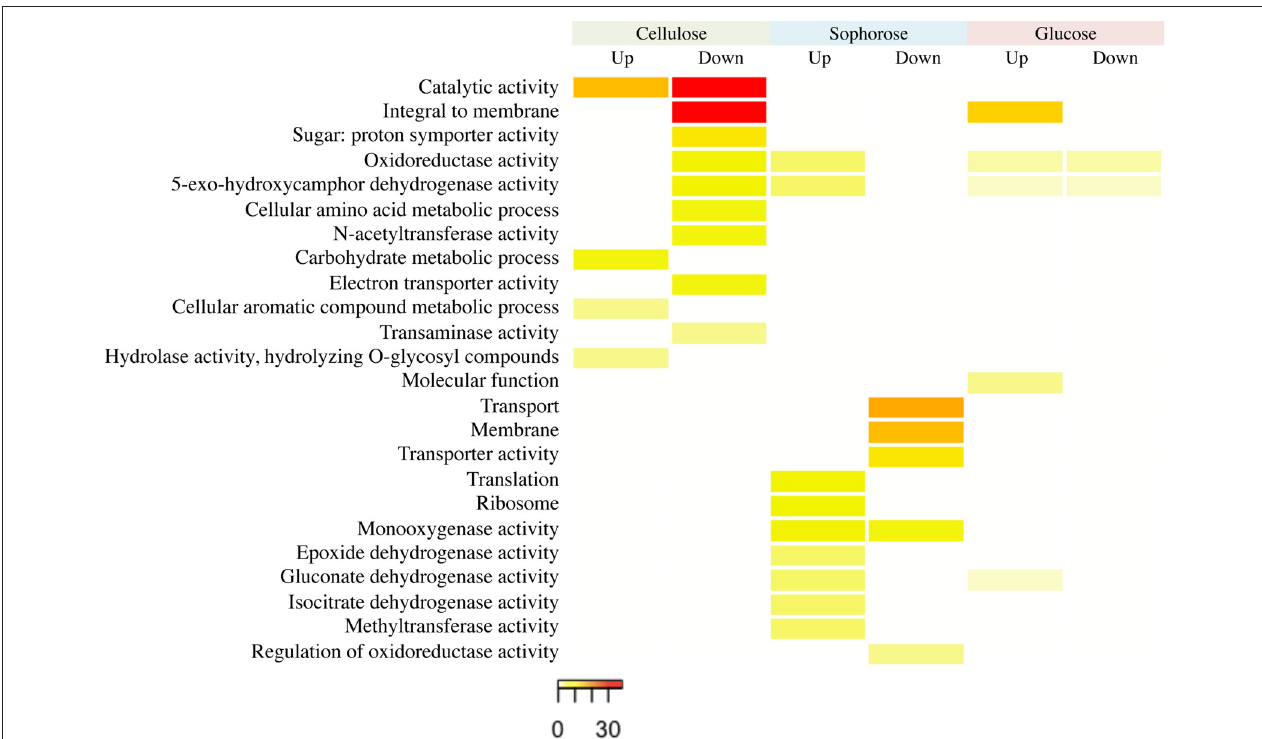
FIGURE 3 | GO enrichment analysis of up- and down-regulated genes of the ∆ xyr1 strain compared to parental strain QM9414 grown in cellulose, sophorose, and glucose as sole carbon sources. The enriched GO terms according to molecular function, cellular component, and biological process in T. reesei . Significantly enriched categories ( P ≤ 0 .05) are